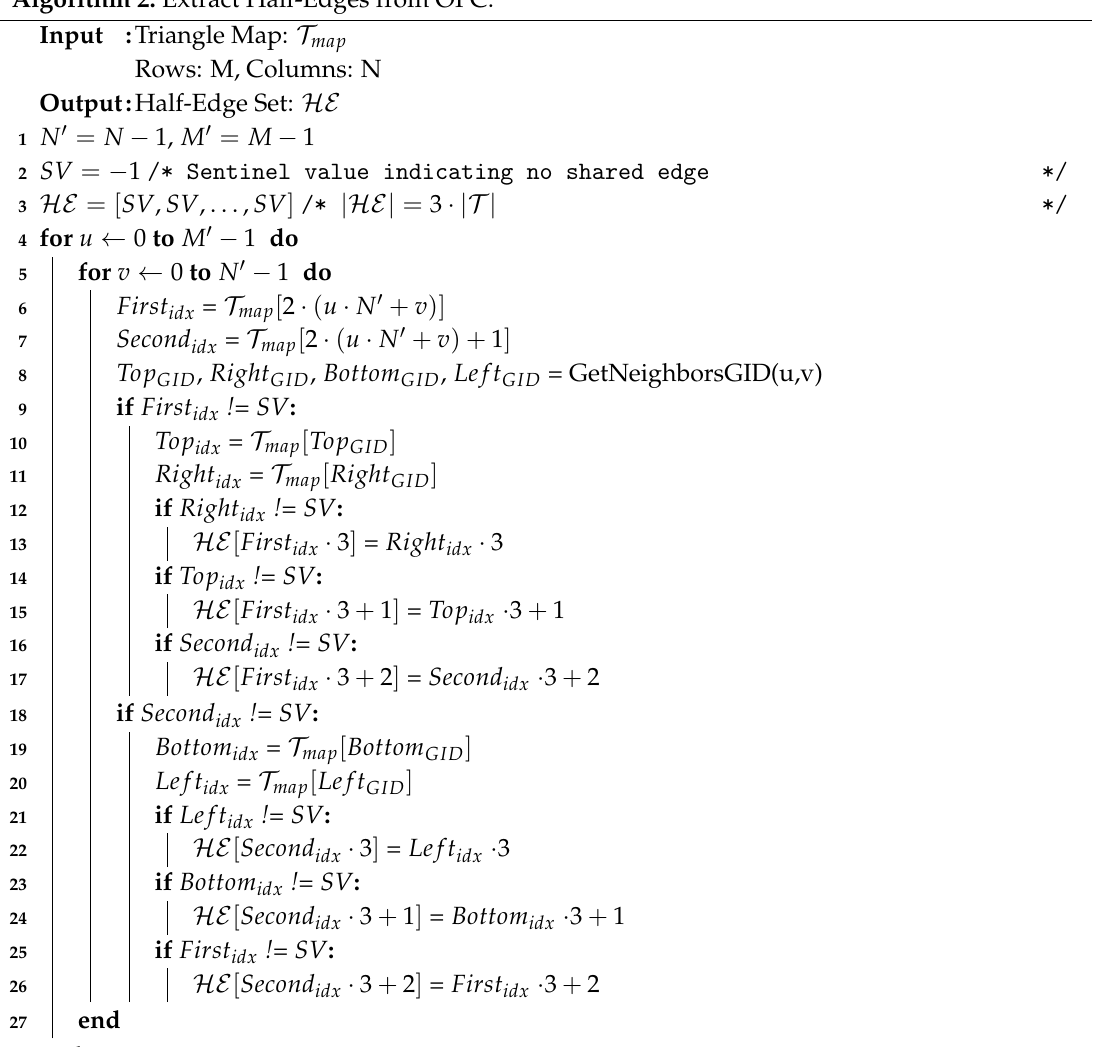
Algorithm 2: Extract Half-Edges from